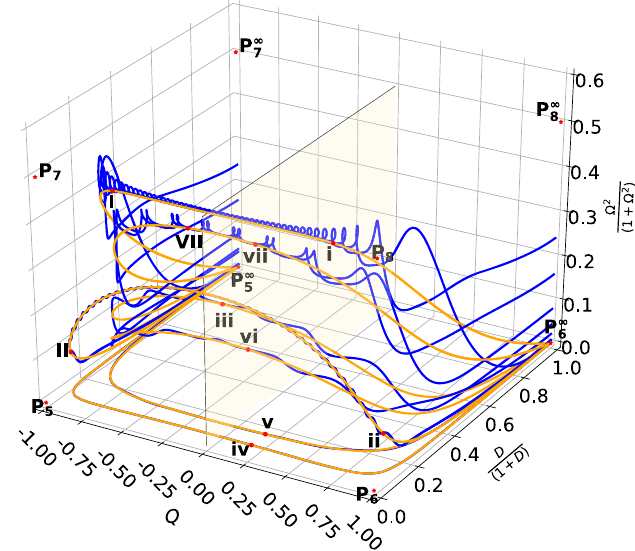
Fig. 24 Some solutions of the full system (118) (blue) and time-averaged system (145) (orange) for the FLRW metric with positive curvature ( k = + 1) when γ = 2. We have used for both systems the initial data sets presented in Table